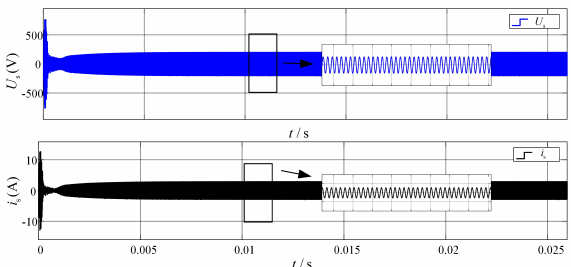
Fig. 12. Simulation waveform of receiving coil voltage u s and current i